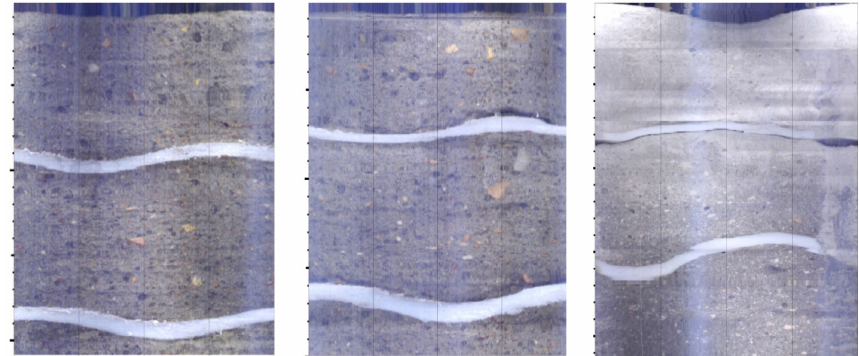
Figure 10. Partial borehole wall images.